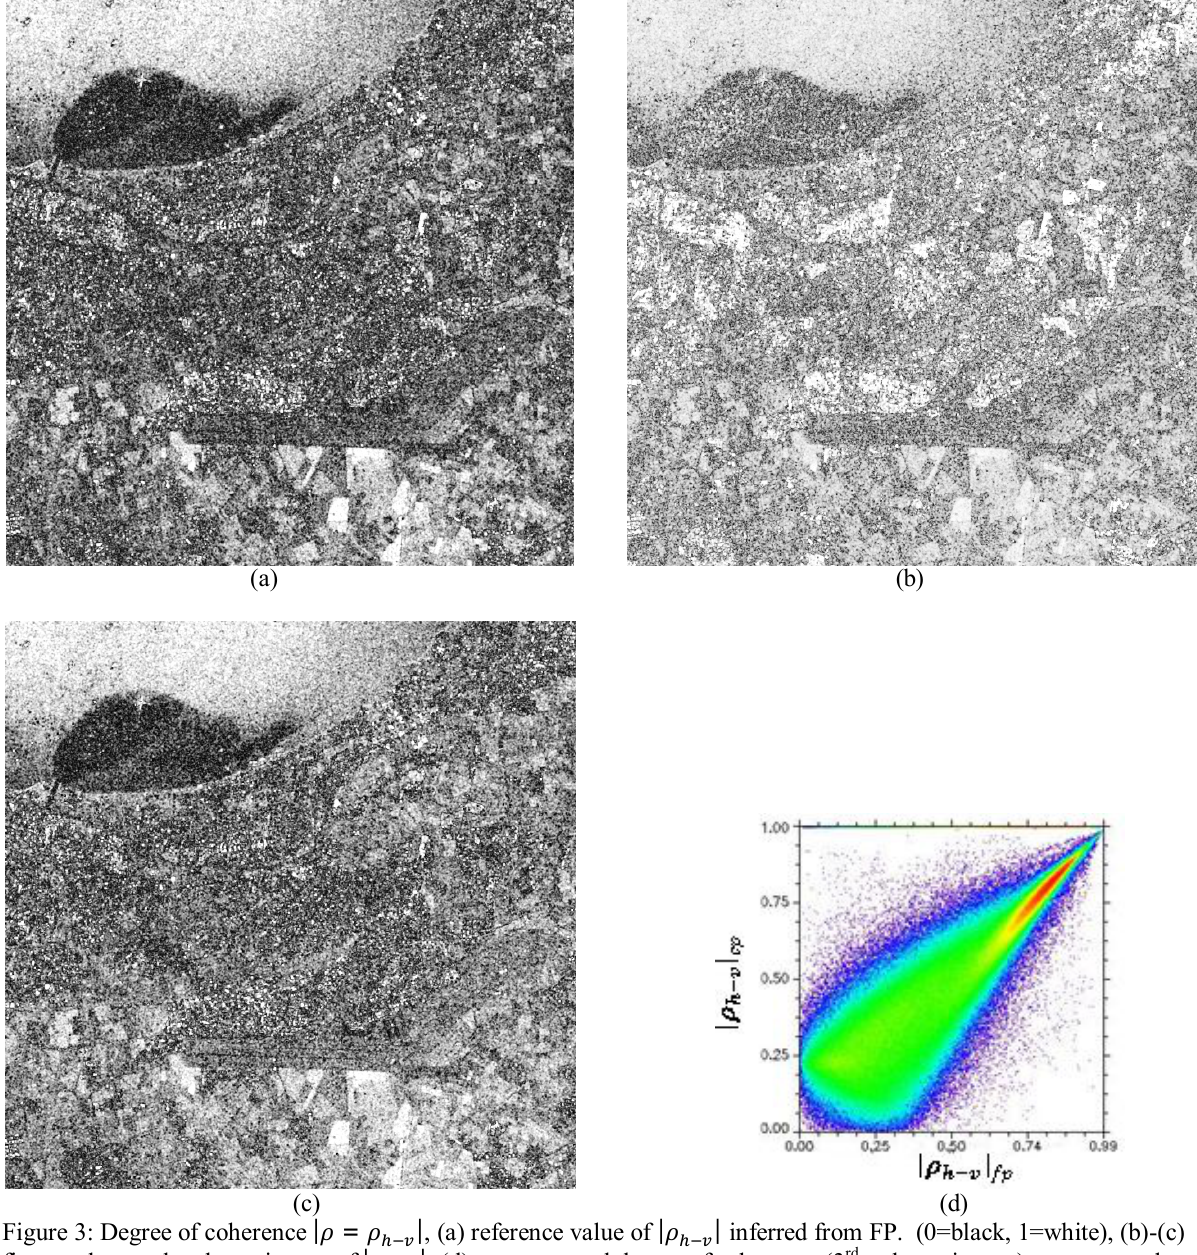
Figure 3: Degree of coherence | (cid:2025) = (cid:2025) (cid:3035)(cid:2879)(cid:3049) | , (a) reference value of | (cid:2025) (cid:3035)(cid:2879)(cid:3049) | inferred from FP. (0=black, 1=white), (b)-(c) first- and second-order estimates of | (cid:2025) (cid:3035)(cid:2879)(cid:3049) | , (d) reconstructed degree of coherence (3 rd order estimates) versus actual degree of coherence (reference value